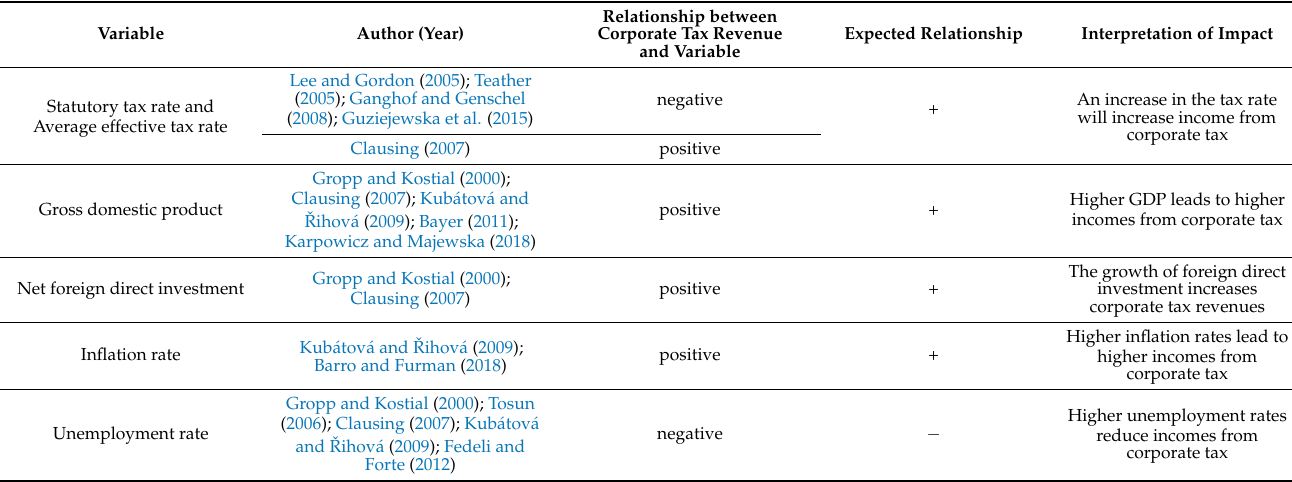
Table 1. Expected impact of selected variables on corporate tax